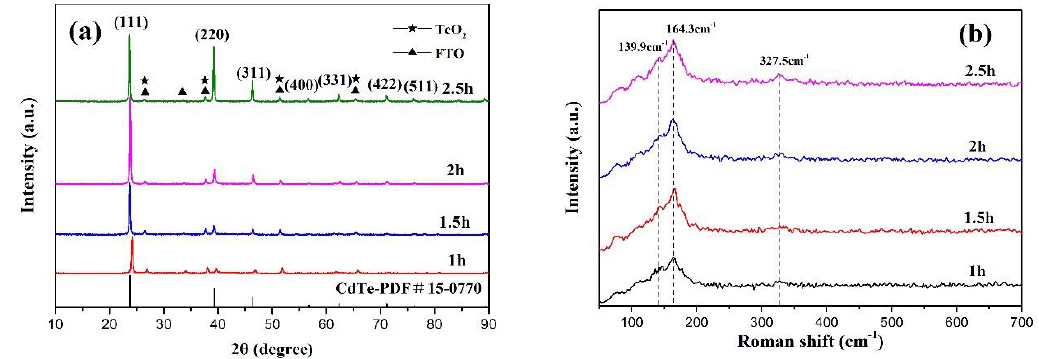
Figure 2. ( a ) XRD patterns of CdTe thin films with deposition time of 1 h, 1.5 h, 2 h, and 2.5 h, respectively; ( b ) Raman spectra of CdTe thin films with deposition time of 1 h, 1.5 h, 2 h, and 2.5 h, respectively.